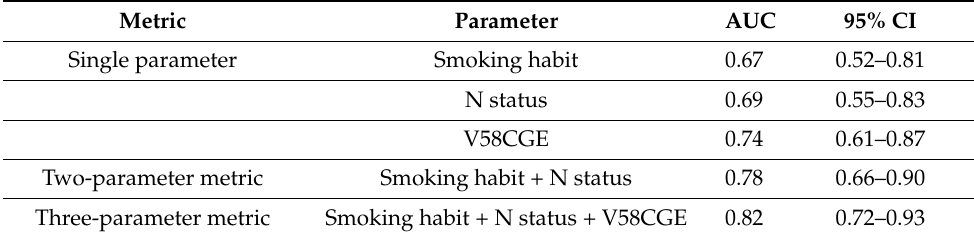
Table 4. AUC value to predict grade 2 and 3 acute radiation dermatitis.